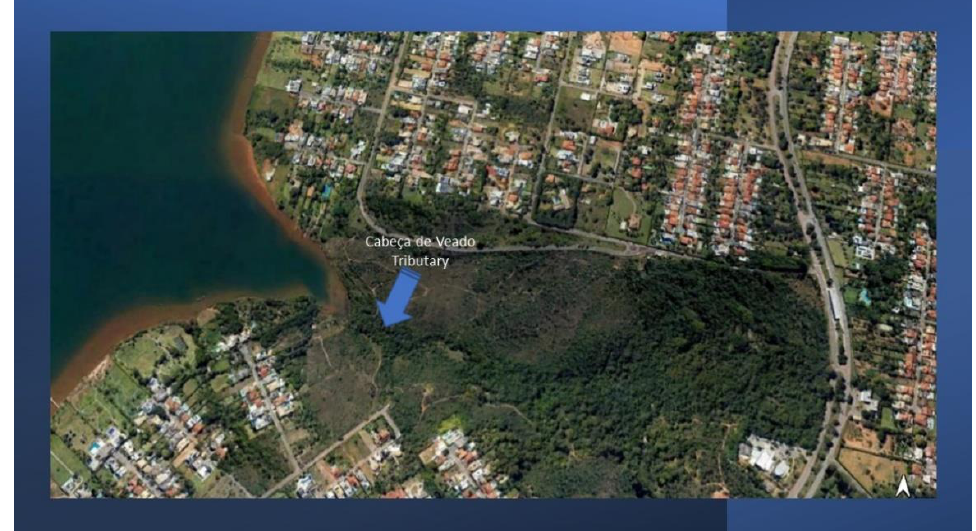
Figure 10. Satellite image (Goggle Earth ® ) showing Cabeça de Veado tributary and its surrounding area.